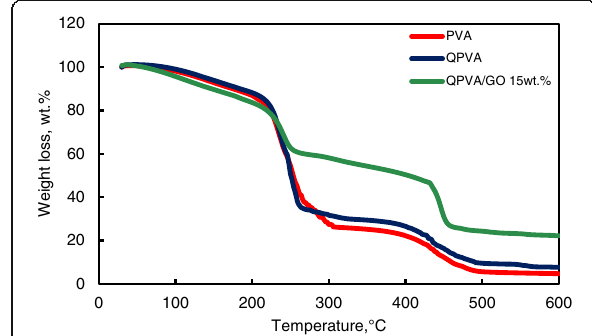
Fig. 7 TGA analysis of PVA membrane, QPVA membrane and QPVA/ GO composite